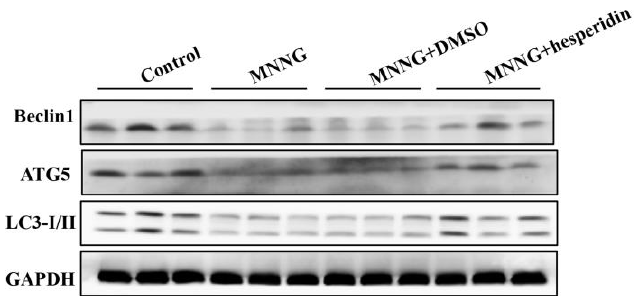
Figure 5. Hesperidin activated autophagy in rats’ gastric tissues elicited by MNNG. Rats were divided into a control group, an MNNG group, an MNNG and solvent control group, and an MNNG and hesperidin group. Analysis of protein expression of autophagy markers was by Western blotting. Tissues were from n = 3 rats as representative images.